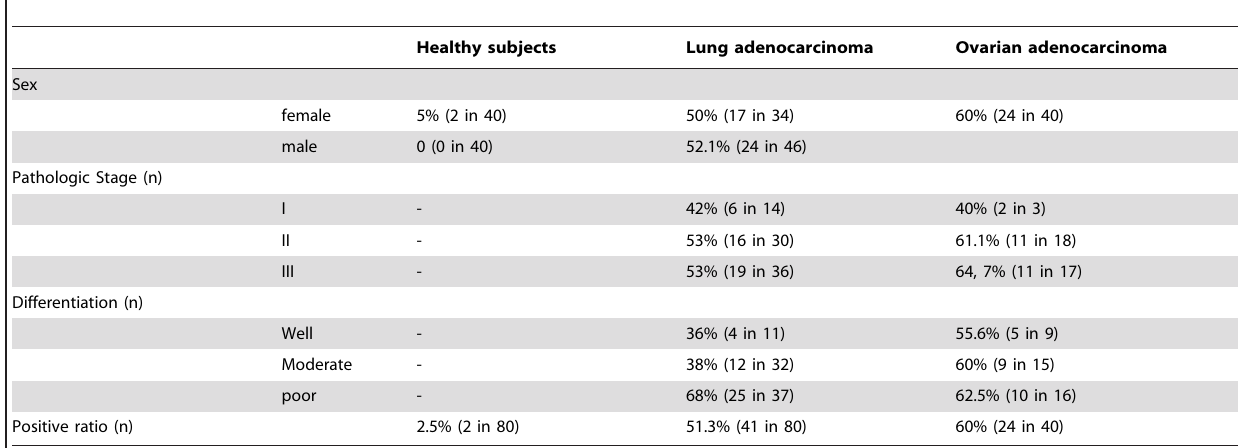
Table 2. The positive ratio of serum FST levels in healthy subjects, patients with lung and ovarian mucinous adenocarcinoma.